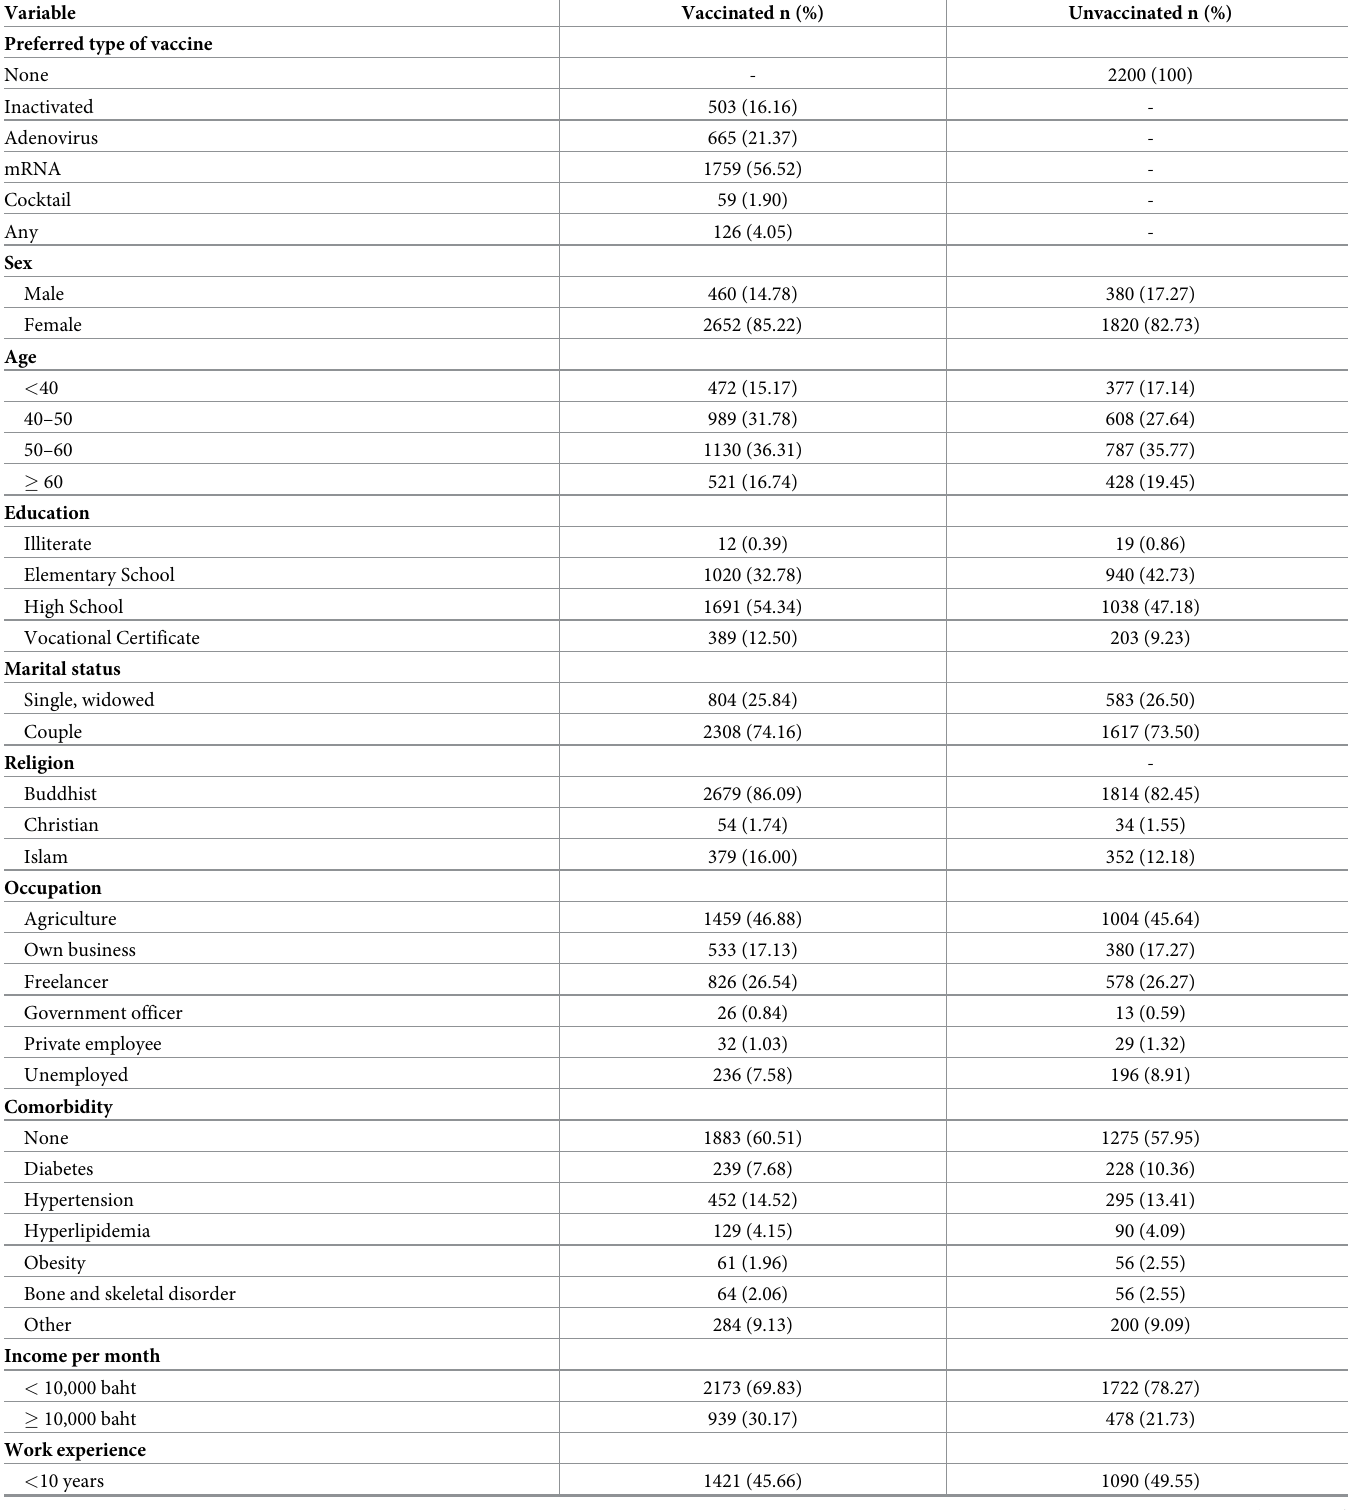
Table 1. Demographic, literacy, fear and hesitancy vaccine scores of Thai village health